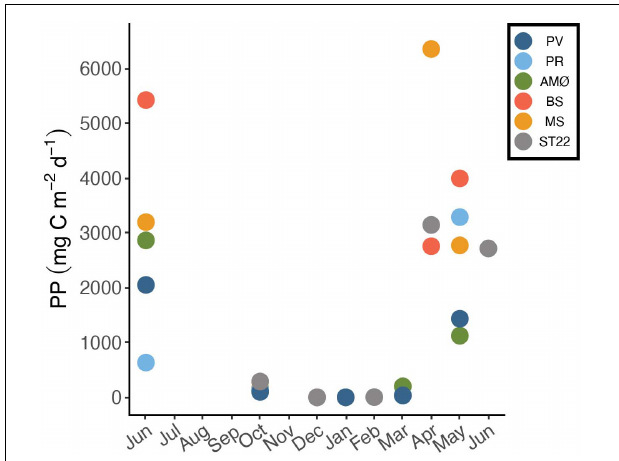
FIGURE 4 | Daily net primary production (PP) of phytoplankton as an average carbon consumption (mg C m − 2 d − 1 ) in 0–50 m between June 2018 and 2019. Stations are marked with different